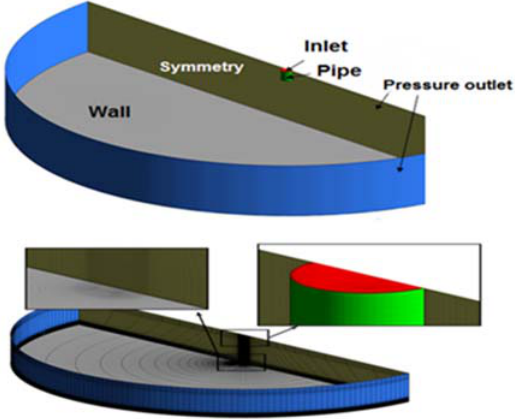
Figure 2. Jet impingement geometry, boundary conditions, and grid strategy.